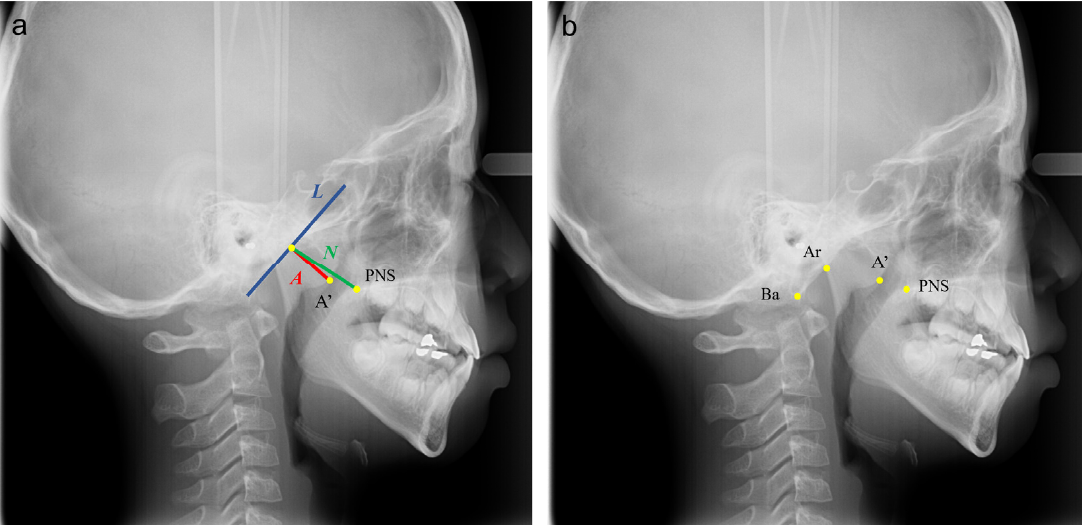
Figure 1. The A/N ratio measurement ( a ); annotated images with four keypoints landmarked ( b ). (A’ is the point of maximal convexity along the inferior margin of adenoid shadow; PNS is the posterior superior edge of the hard palate; Ba is the most inferior-posterior point on the margin of the foramen magnum; Ar is the intersection of the inferior cranial base surface and the averaged posterior surfaces of the mandibular condyles; line segment L is drawn along the straight part of the anterior margin of the basiocciput; line segment A indicates the size of the adenoid; line segment N indicates the size of the nasopharyngeal space).